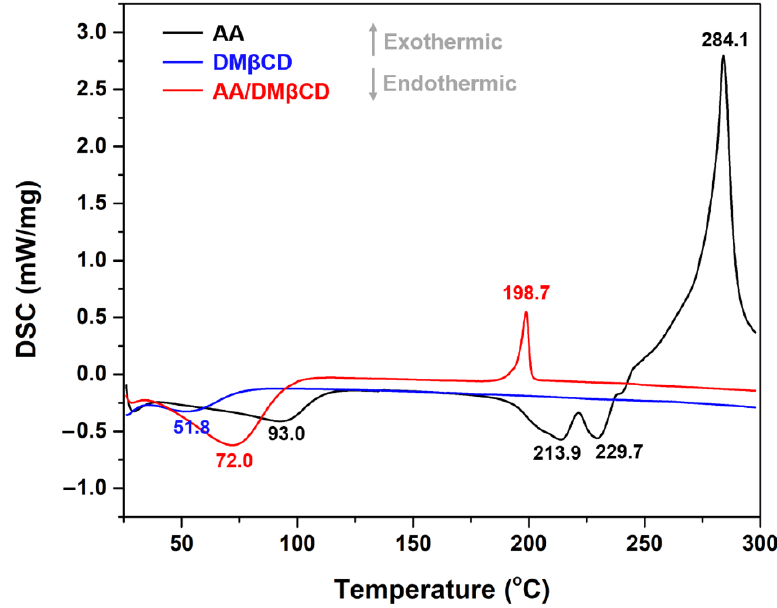
Figure 5. DSC thermograms of the AA, DM β CD, and AA/DM β CD complex.